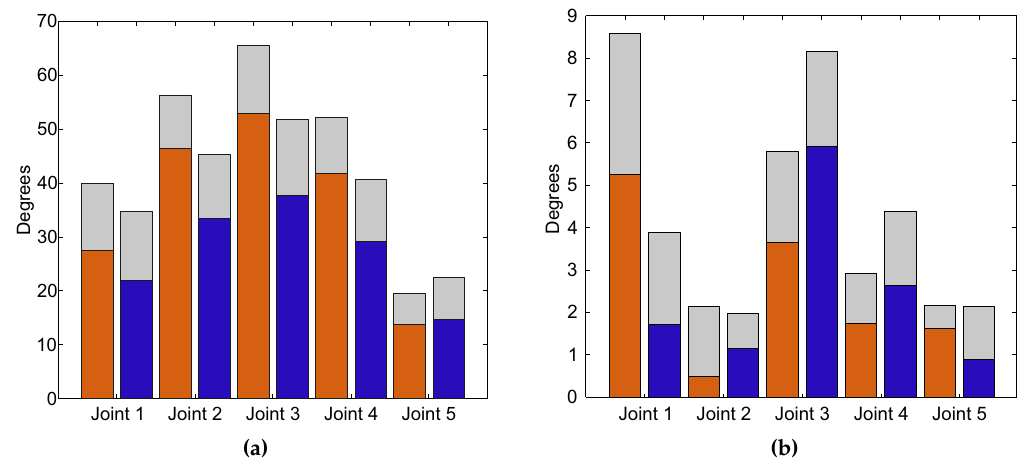
Figure 7. Representation of both trials: without compensation (orange bar) and with compensation (blue bar), and the standard deviation (gray bar) in terms of arm joints. ( a ) Estimated range of motion (ROM); ( b ) Error committed between the real ROM and the estimated ROM.